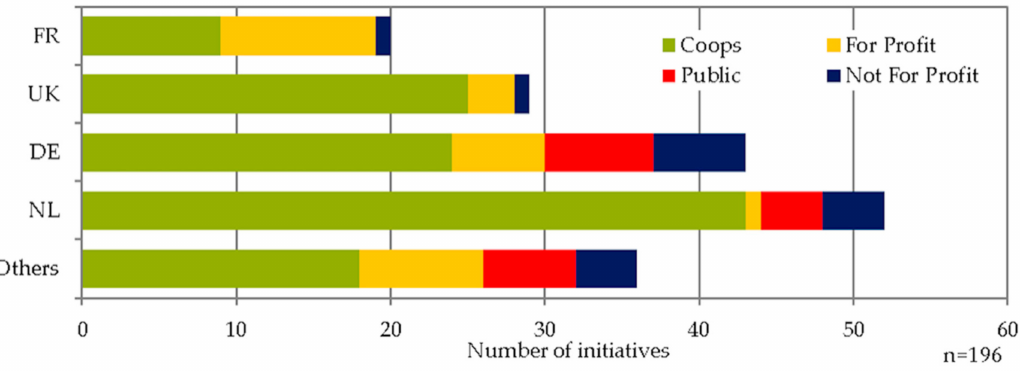
Figure 1. Distribution of legal